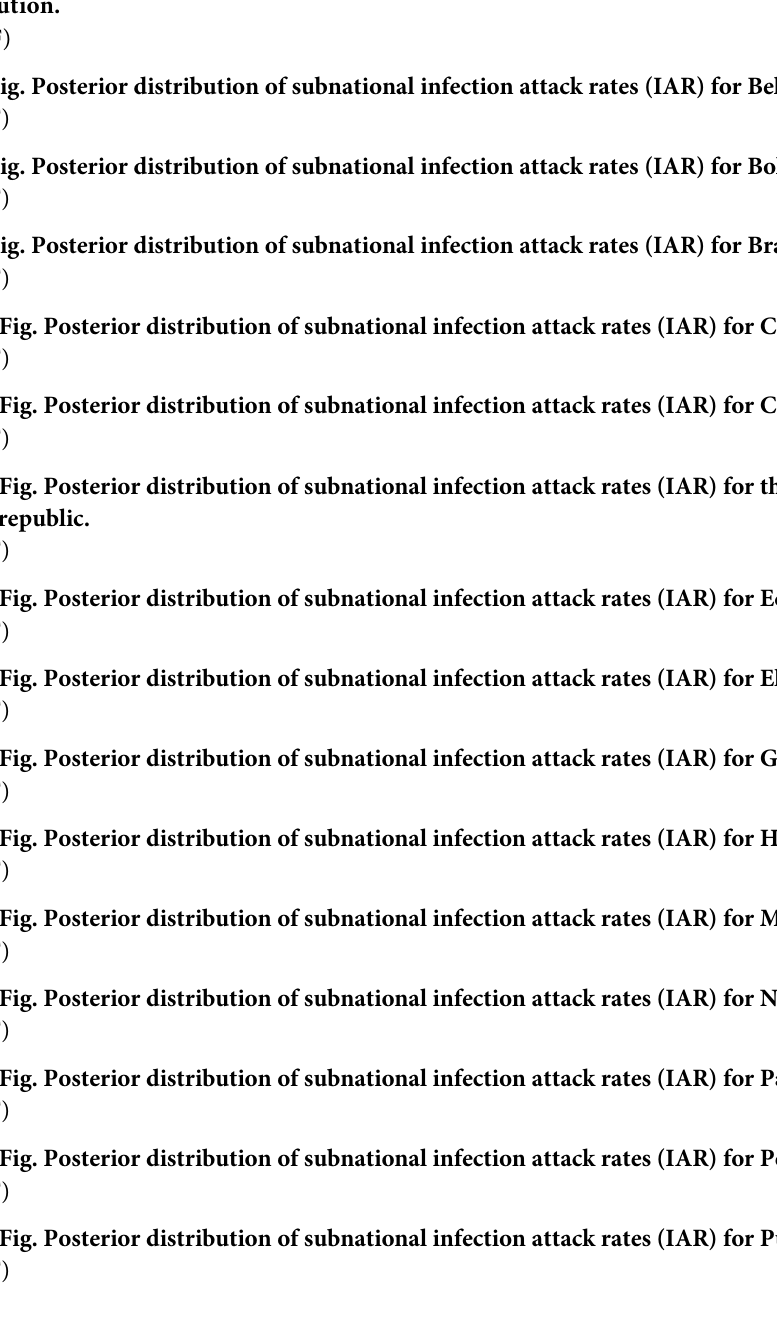
(TIF) S5 Fig. Comparison of posterior national-level IAR estimates for four countries when the reporting process for suspected cases was modeled using a binomial or Poisson distribution. (TIF) S6 Fig. Comparison of posterior national-level IAR estimates for four countries when the reporting process for suspected cases was modeled using a binomial or Poisson dis- tribution. (TIF) S7 Fig. Posterior distribution of subnational infection attack rates (IAR) for Belize. (TIF) S8 Fig. Posterior distribution of subnational infection attack rates (IAR) for Bolivia. (TIF) S9 Fig. Posterior distribution of subnational infection attack rates (IAR) for Brazil. (TIF) S10 Fig. Posterior distribution of subnational infection attack rates (IAR) for Colombia. (TIF) S11 Fig. Posterior distribution of subnational infection attack rates (IAR) for Costa Rica. (TIF) S12 Fig. Posterior distribution of subnational infection attack rates (IAR) for the Domini- can republic. (TIF) S13 Fig. Posterior distribution of subnational infection attack rates (IAR) for Ecuador. (TIF) S14 Fig. Posterior distribution of subnational infection attack rates (IAR) for El Salvador. (TIF) S15 Fig. Posterior distribution of subnational infection attack rates (IAR) for Guatemala. (TIF) S16 Fig. Posterior distribution of subnational infection attack rates (IAR) for Honduras. (TIF) S17 Fig. Posterior distribution of subnational infection attack rates (IAR) for Mexico. (TIF) S18 Fig. Posterior distribution of subnational infection attack rates (IAR) for Nicaragua. (TIF) S19 Fig. Posterior distribution of subnational infection attack rates (IAR) for Panama. (TIF) S20 Fig. Posterior distribution of subnational infection attack rates (IAR) for Peru. (TIF) S21 Fig. Posterior distribution of subnational infection attack rates (IAR) for Puerto Rico.